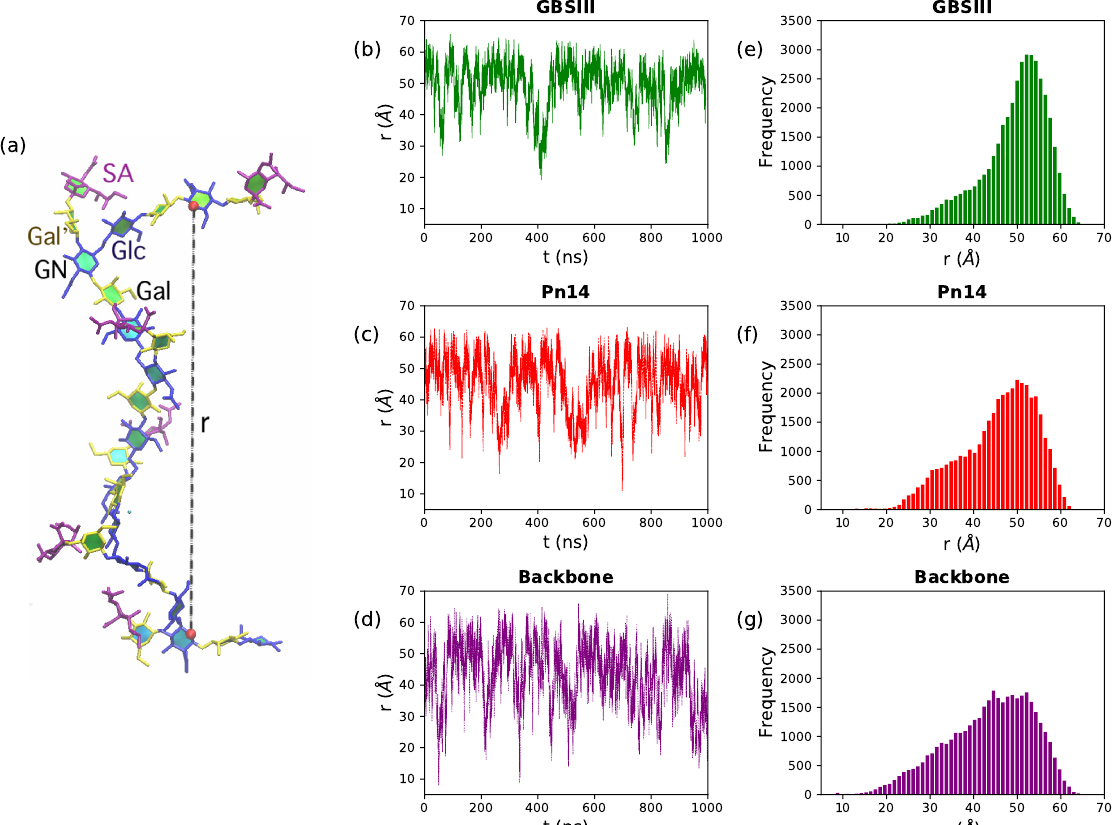
Figure 2. Polysaccharide end-to-end distance distributions for the 6RU PS. ( a ) The molecular end-to-end distance, r , is defined as the distance between O5 atoms in GlcNAc residues in RU1 and RU6, here shown on the GBSIII PS. The center column shows the r time series for ( b ) GBSIII PS, ( c ) Pn14 PS and ( d ) unbranched backbone PS. The corresponding distance distributions are in the rightmost column for ( e ) GBSIII PS, ( f ) Pn14 PS and ( g ) the unbranched backbone